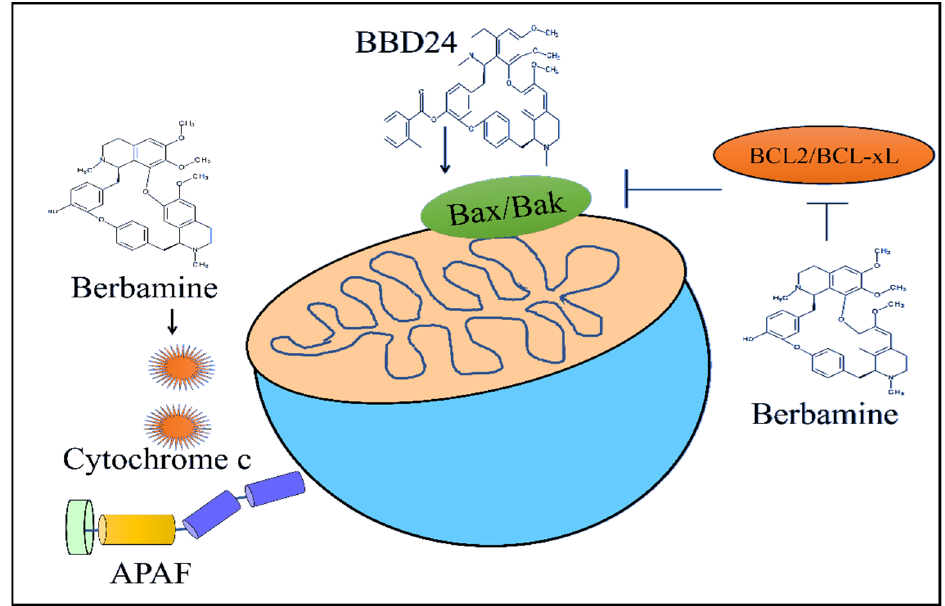
Figure 3. Berbamine reduced Bcl-XL and Bcl-2 but enhanced the release of cytochrome c. 2- methylbenzoyl berbamine (BBD24) increased Bax level.